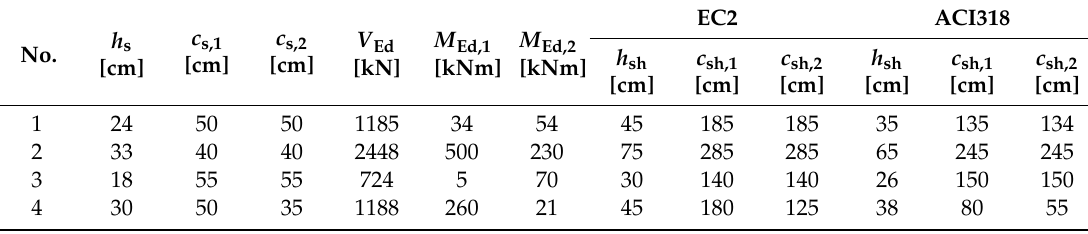
Table 4. The shear heads dimensions determined in verification